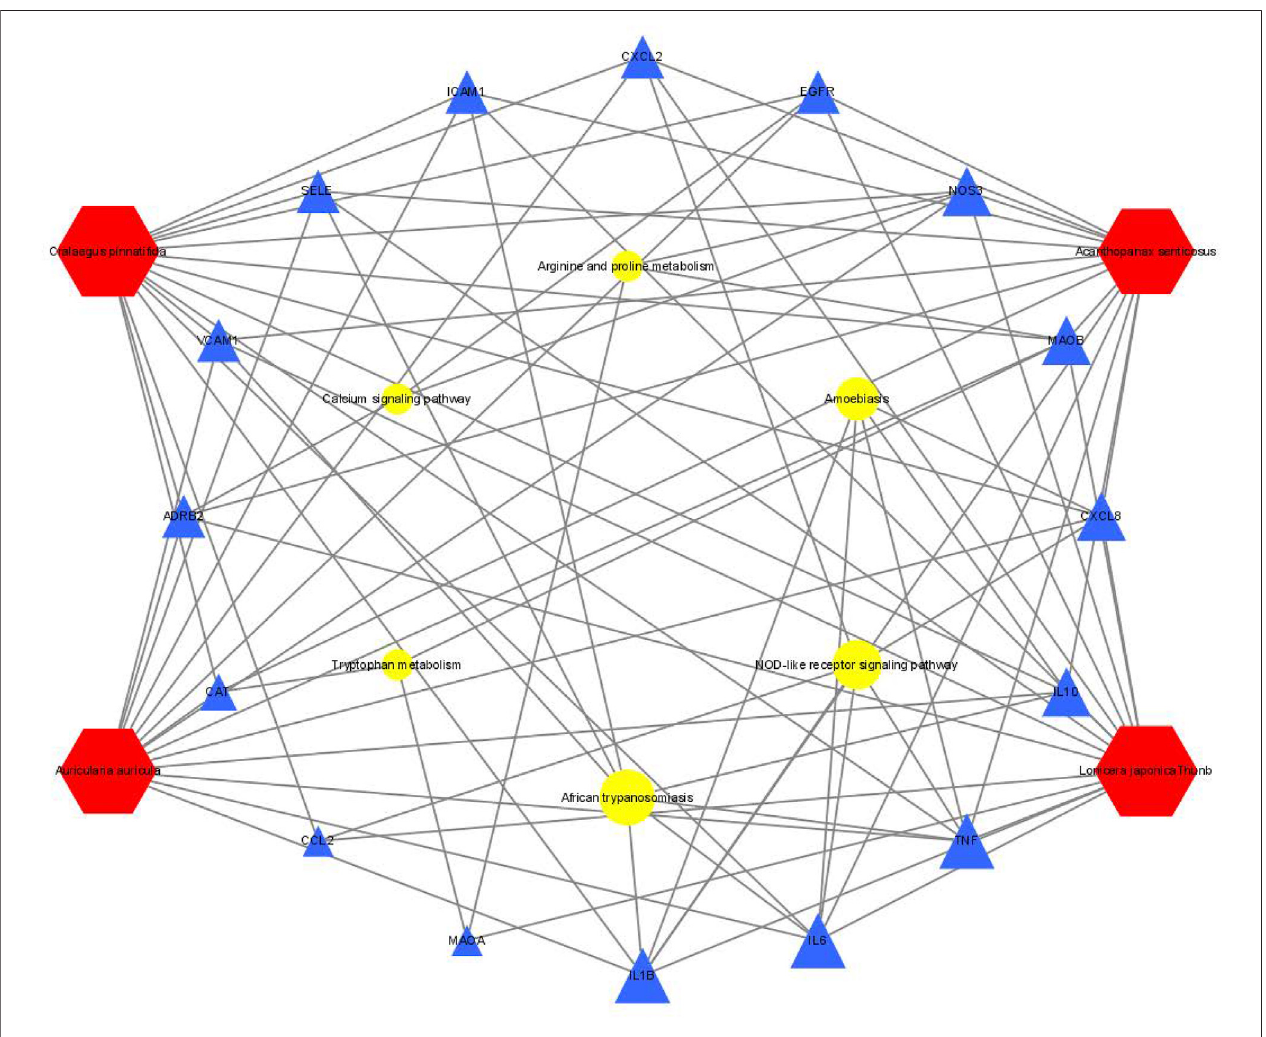
FIGURE 7 | Integrated network plot for SEJZ in hyperlipidemia